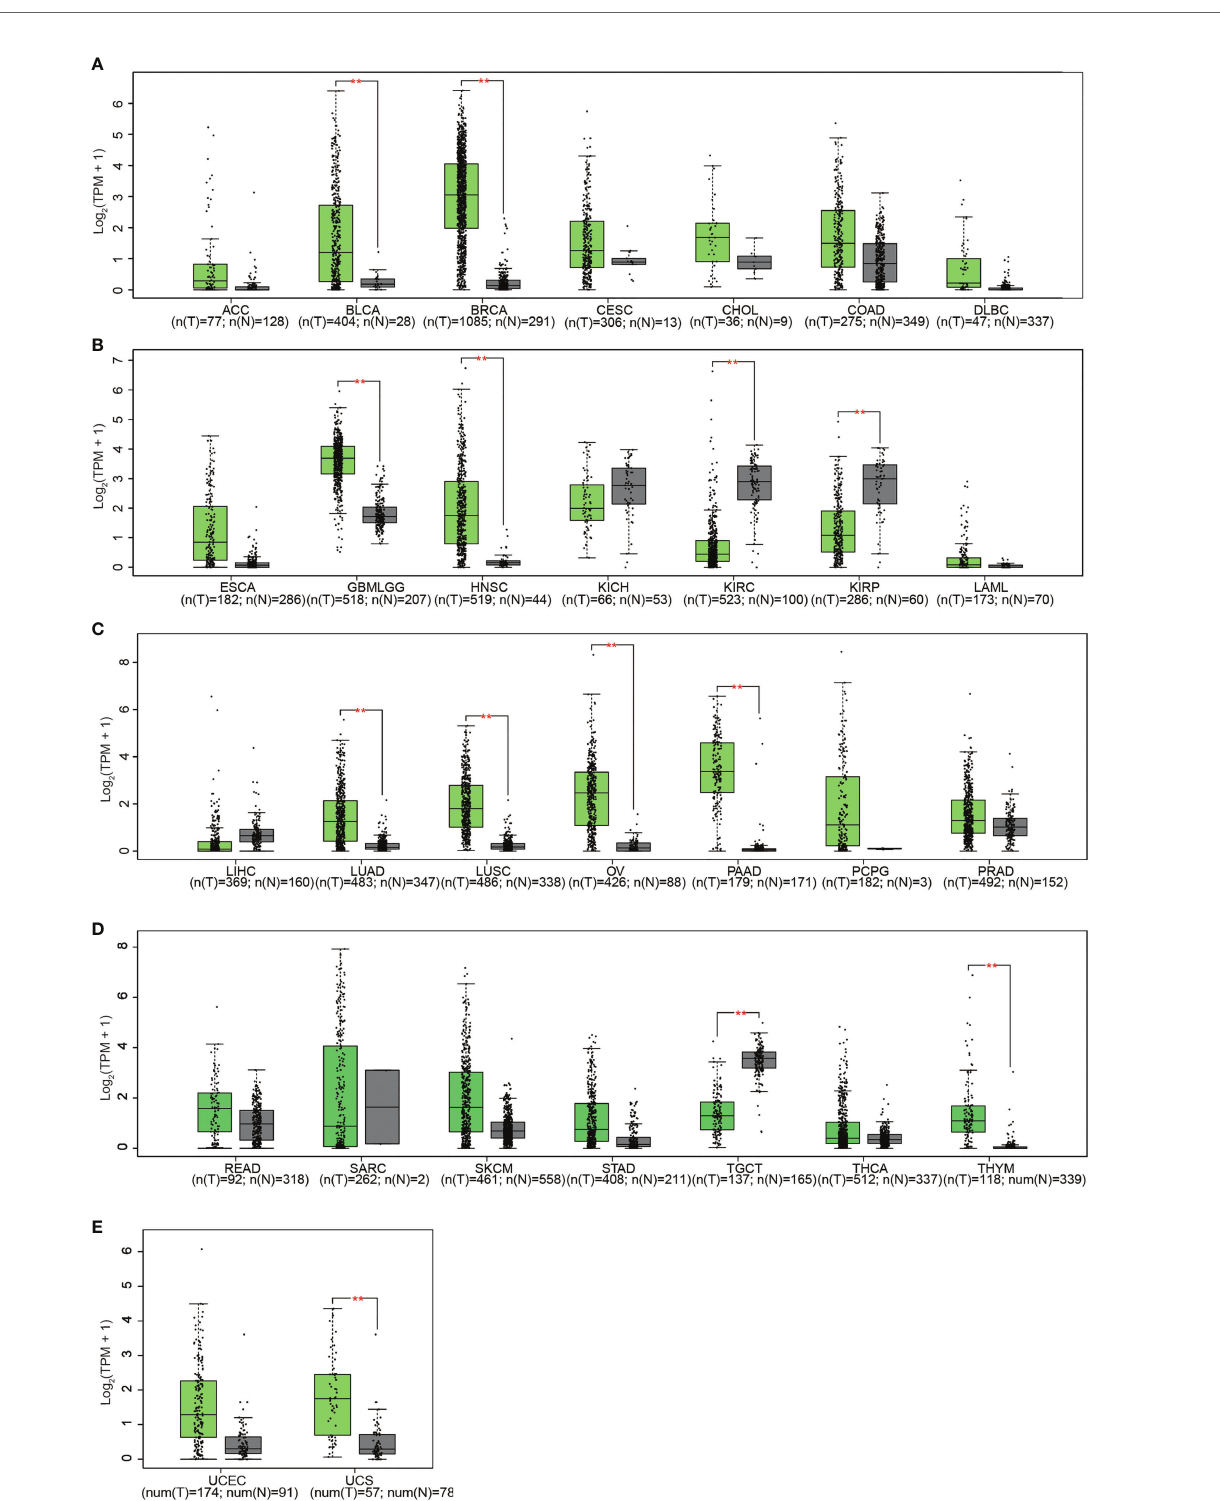
FIGURE 2 | (A) The relative expression levels of PLPP4 in ACC, BLCA, BRCA, CESC, CHOL, COAD, DLBC, compared with normal tissues. (B) Compared with normal tissues, the relative expression levels of PLPP4 in ESCA, GBMLGG, HNSC, KICH, KIRC, KIRP, LAML. (C) Compared with normal tissues, the relative expression levels of PLPP4 in LIHC, LUAD, LUSC, OV, PAAD, PCPG, PRAD. (D) Compared with normal tissues, the relative expression levels of PLPP4 in READ, SARC, SKCM, STAD, TGCT, THCA, THYM. (E) Compared with normal tissues, the relative expression levels of PLPP4 in UCEC, UCS. "**"means compared to normal, ** P <